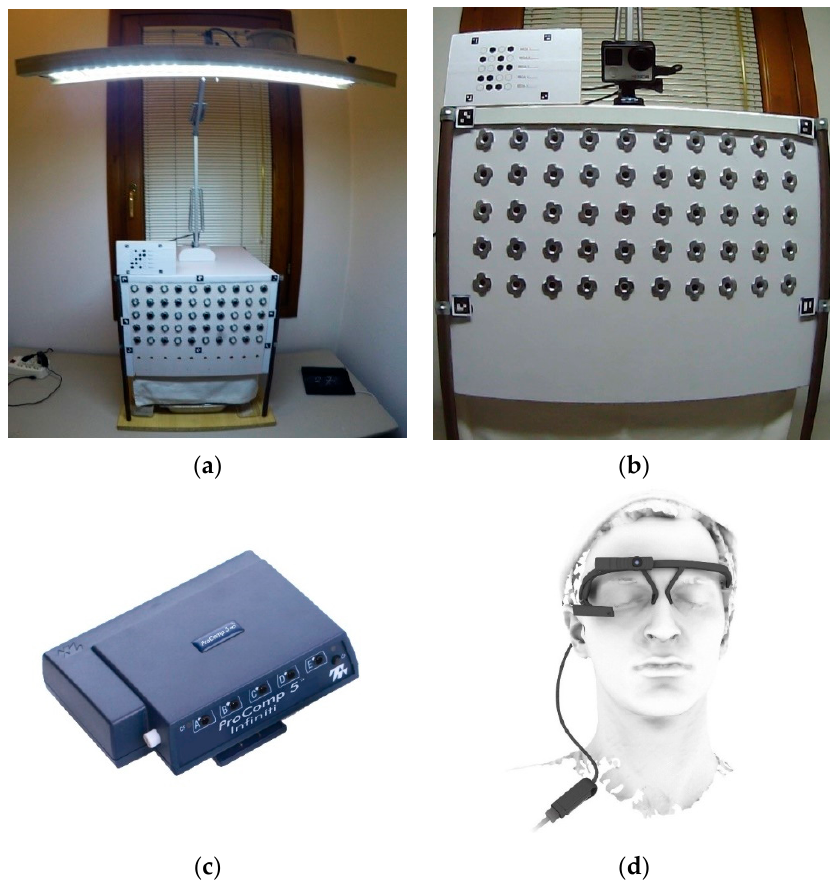
Figure 2. Components of the ad hoc workstation. ( a ) Blackboard distant view; ( b ) blackboard front view; ( c ) ProComp5 Infiniti; ( d ) Pupil Labs glasses.